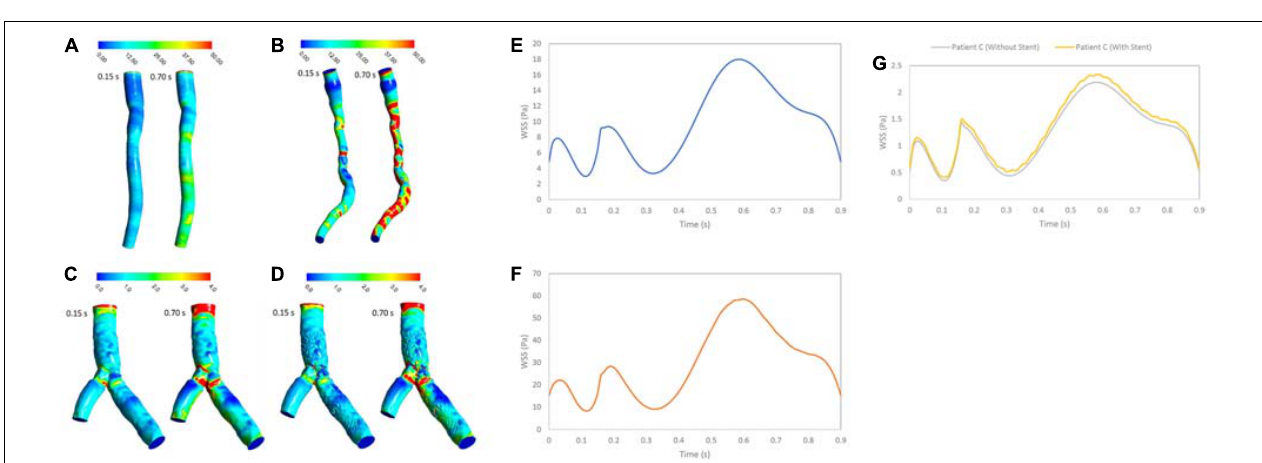
FIGURE 3 | WSS (Pa) (A) for patient A, (B) for patient B, (C) for patient C without stent, and (D) with stent during both systole (0.15 s of pulse) and diastole (0.7 s of pulse), and WSS (Pa) (E) for patient A, (F) for patient B, and (G) for patient C in a cardiac cycle.